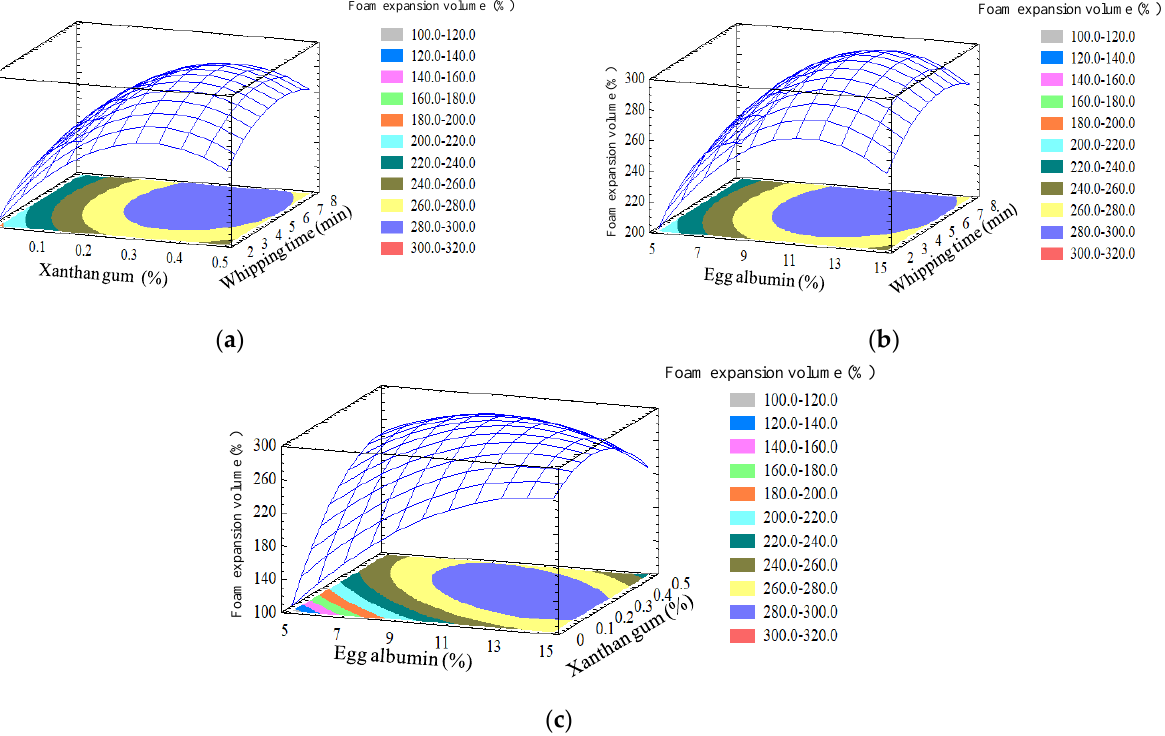
Standard Error of Est. = 4.18. The response surface and contour plots of each pair of factors were presented in Figure 2. It was observed that xanthan gum and egg albumin concentrations have a similar effect on foam expansion compared with foam density because both reactions are related; greater foam expansion leads to lesser foam density. The combination of factor levels which maximizes foam expansion volume over the indicated region and the optimization is to be performed. It indicated that the foam expansion volume reached the maximum value (299.479%) at optimum values of egg albumin, xanthan gum, and whipping time at 11.67%, 0.29%, and 5.98 min, respectively.